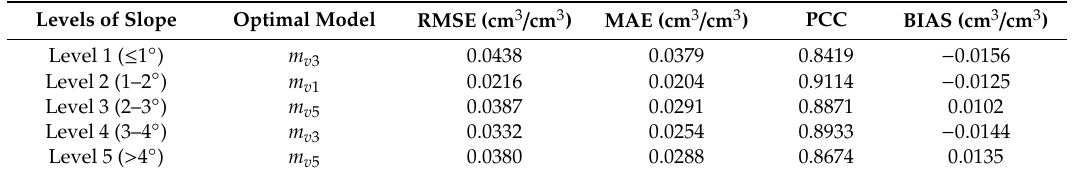
Table 8. Optimal solution modeling strategy based on the slope levels and the accuracy of each algorithm (strategy 3).